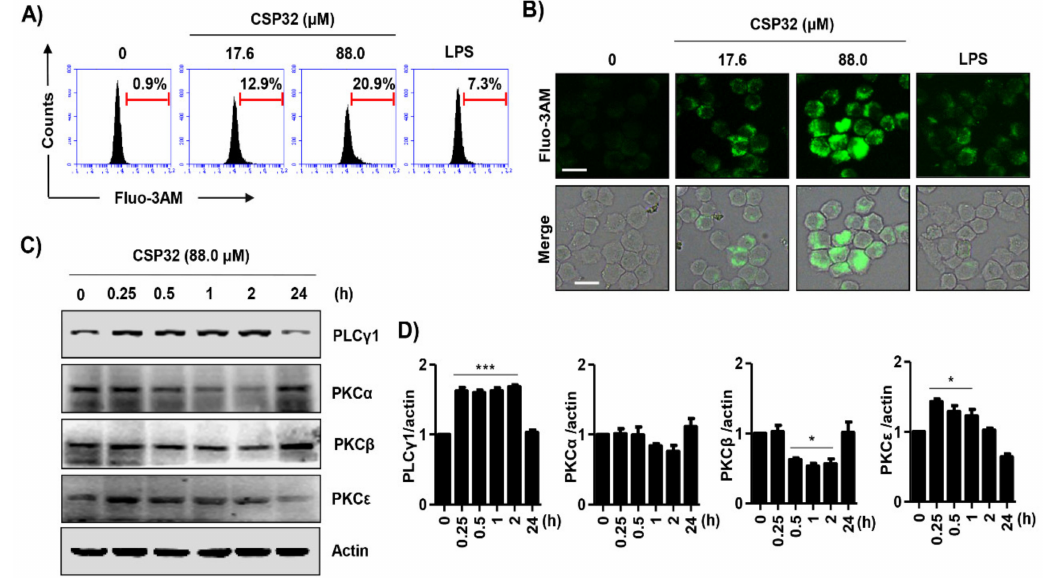
Figure 5. CSP32 upregulated cytosolic Ca 2 + concentrations during M1 polarization. Cells were treated with the indicated concentrations of CSP32 and LPS for 24 h. Then, cells were stained with 2 µ M fluo-3-AM for 30 min. ( A ) Representative histogram from the flow cytometric analysis of fluo-3A-M-positive macrophages following CSP32 and LPS treatment. ( B ) Representative fluorescence images. Scale bar; 20 µ m. ( C ) At 0, 15 min, 30 min, 1 h, 2 h and 24 h after CSP32 treatment, cells were harvested and lysed. Total cell lysates were examined by western blotting for PLC γ 1, PKC α , PKC β , and PKC ε . β -actin was used as an internal control. ( D ) Quantitative analysis of protein expression. The expression of each protein was indicated as a fold change relative to the control. Data are expressed as the mean ± SD ( n = 3). * p < 0.05 and *** p < 0.001 compared with the